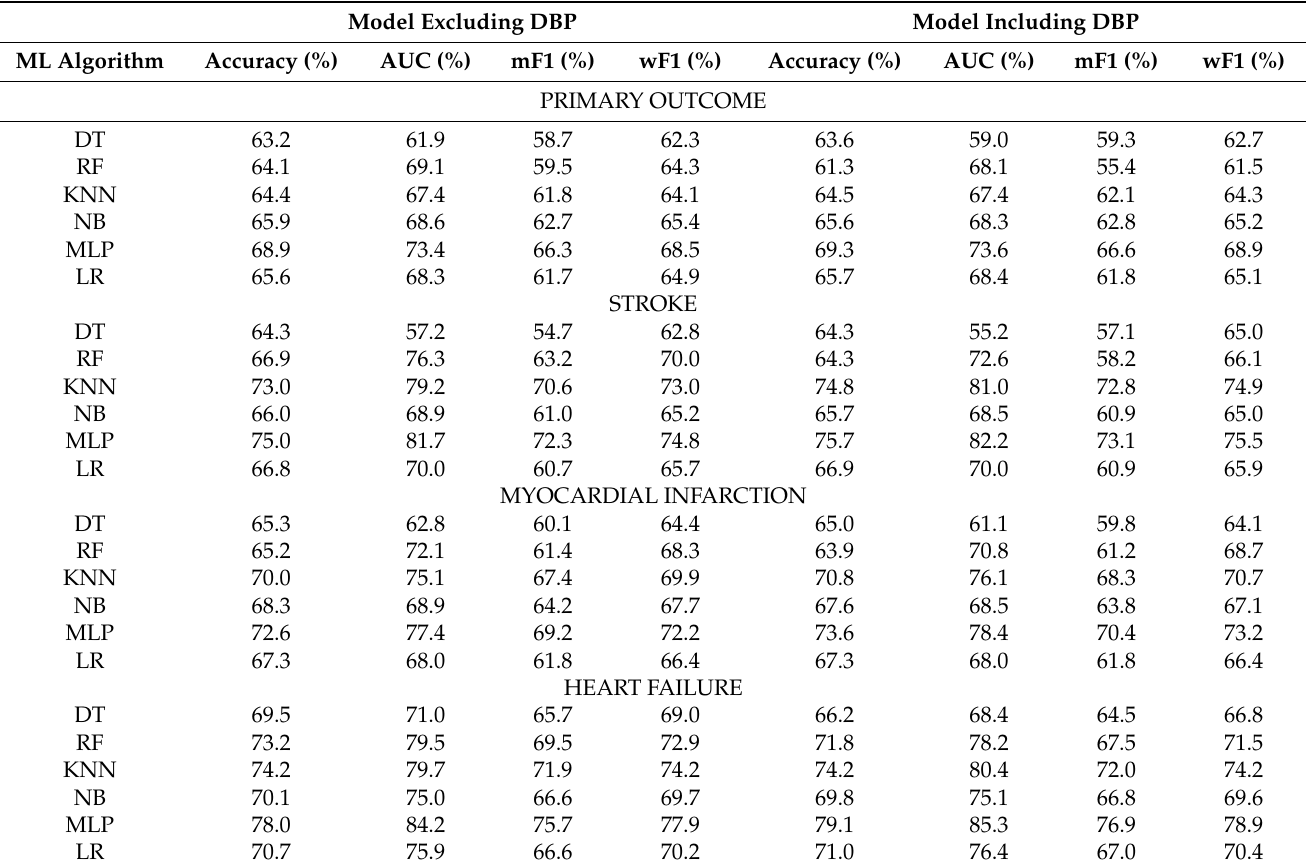
Table 1. Performance of the classifiers for different outcomes, excluding and including diastolic blood pressure in the model for the whole population.